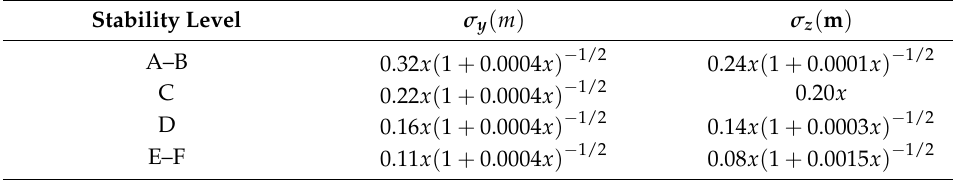
Table 5. Pasquill–Gifford diffusion coefficient